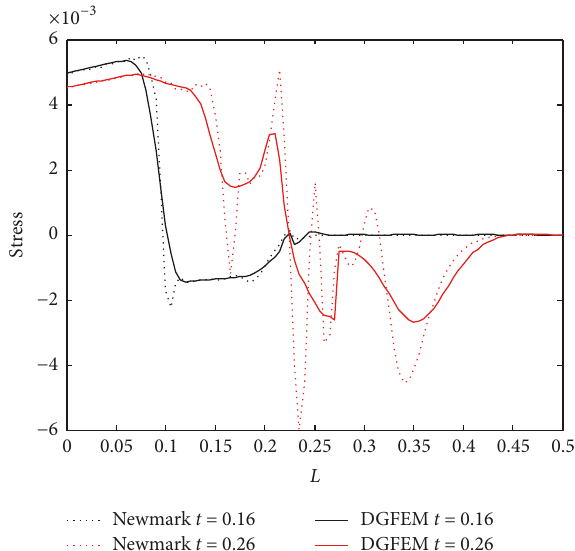
Figure 3: Comparison of the stress profiles at 𝑡 = 0.16 , 𝑡 = 0.20 , and 𝑡 = 0.26 between the proposed DGFEM and the Newmark method.